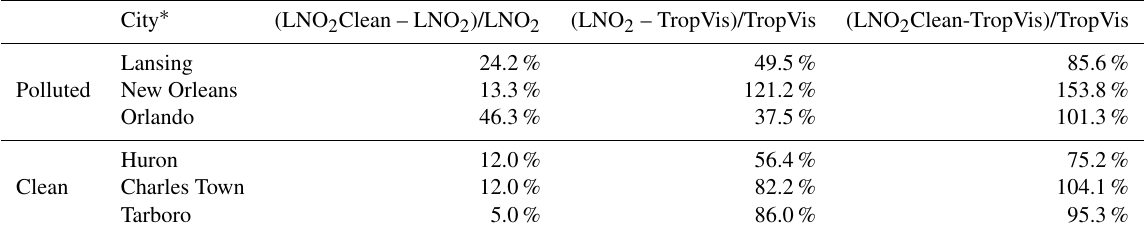
Figure 5. (a, c) Maps of 1 ◦ × 1 ◦ gridded values of mean LNO x and LNO 2 production per flash with CRF ≥ 90% for MJJA 2014. (b, d) Same as (a) and (c) except for strokes. The southeastern US is denoted by the red box in panels (a) – (d) . Table 4. The percent changes in the estimated production when using different methods based on the same a priori